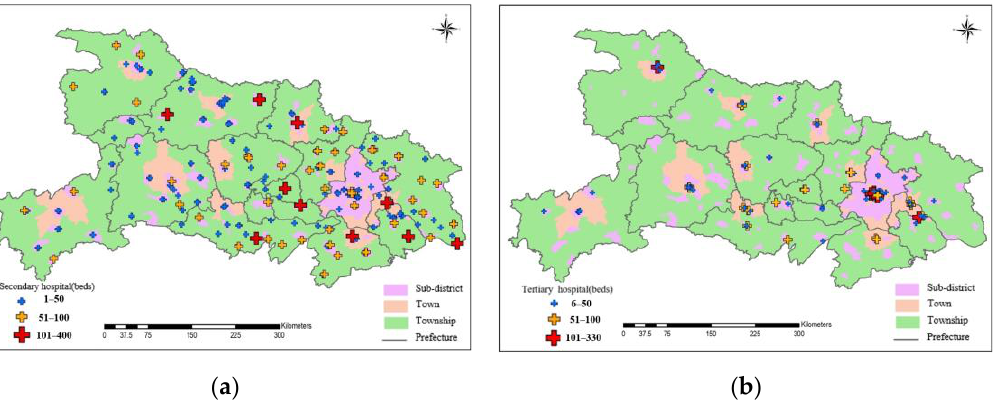
Figure 2. The spatial distribution of obstetrics beds in Hubei in 2016. Including: ( a ) Secondary hospitals; ( b ) Tertiary hospitals.